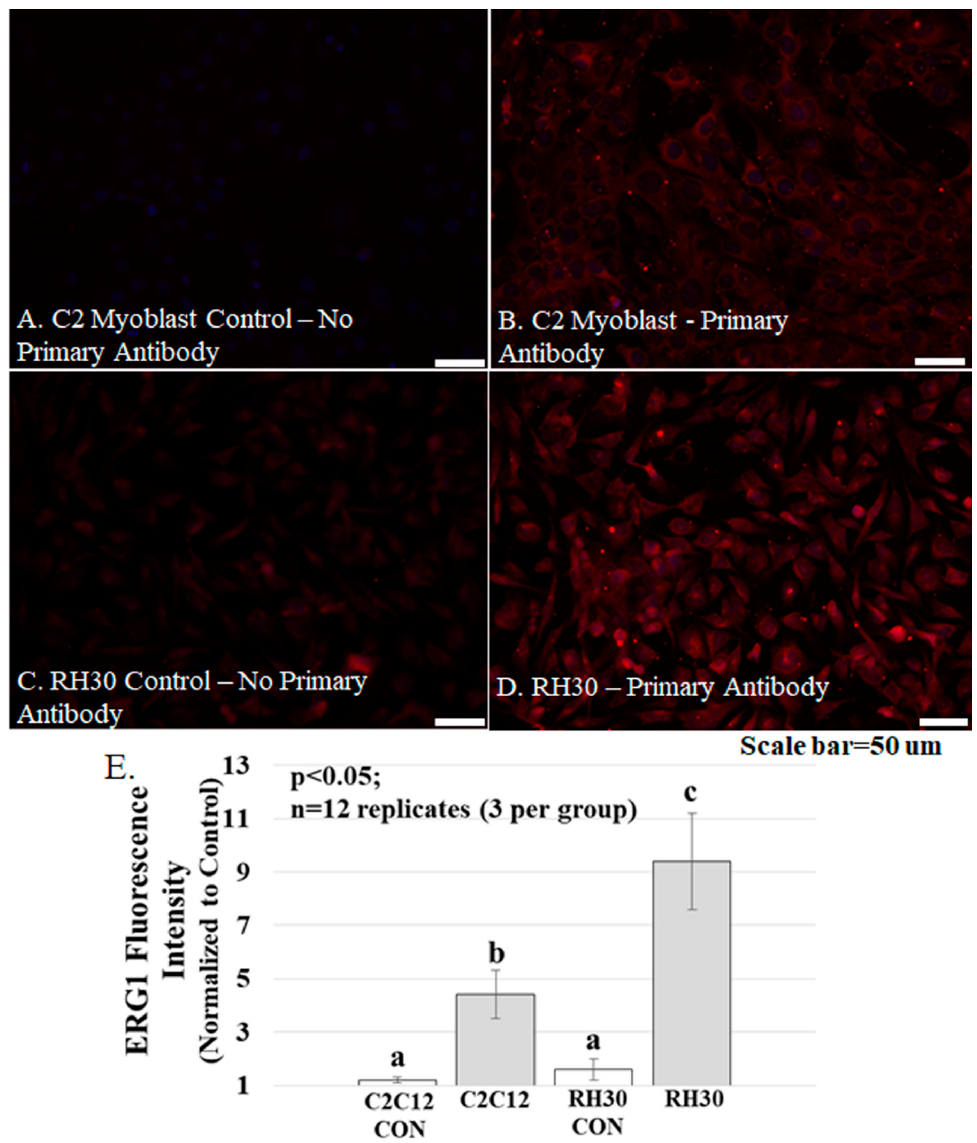
Figure 5. ERG1 protein fluorescence is more abundant in human rhabdomyosarcoma (RH-30) cells Table 2. C12 cells. ( A – D ) Fluorescence was absent from C2C12 ( A ) and RH30 ( C ) control cells immunostained without primary antibody but was evident in the C2C12 ( B ) and RH30 ( D ) cells stained with primary ERG1 antibody. Scale bars represent 50 μ m. All samples were stained and imaged using the same parameters in a single setting; ( E ) ERG1 fluorescence is statistically more abundant in RH30 cells than in non-cancerous C2C12 cells. Graph bars represent mean fluorescence intensity ± the standard error of the mean. Different lower-case letters represent statistical difference ( p < 0.05). Images were acquired using a Leica DM4500 microscope with a Leica DFC 340FX camera. Immunoblot. Membrane proteins were extracted from human skeletal muscles [35], and the protein content of each homogenate was measured using a DC Protein Assay Kit (Bio-Rad; Hercules, CA, USA). Aliquots of equal protein content were immunoblotted as